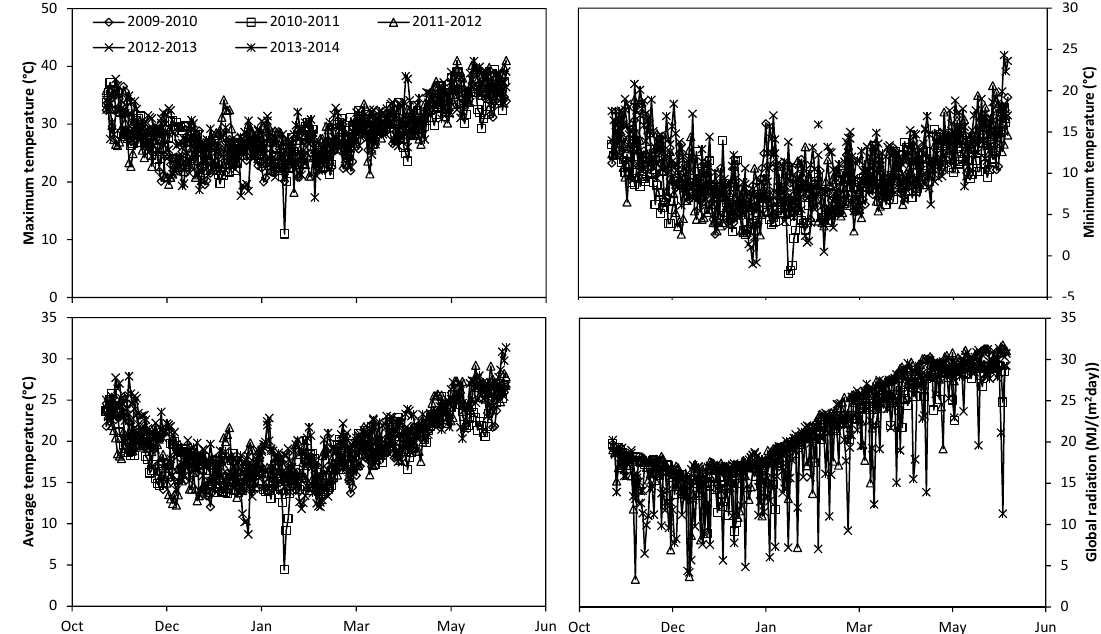
Figure 1. Maximum, minimum, average temperatures, and radiation occurring during five wheat growing cycles (2009–2010 to 2013–2014) at the International Maize and Wheat Improvement Center (CIMMYT), in the Yaqui valley, near Ciudad Obregon, Sonora, Mexico.